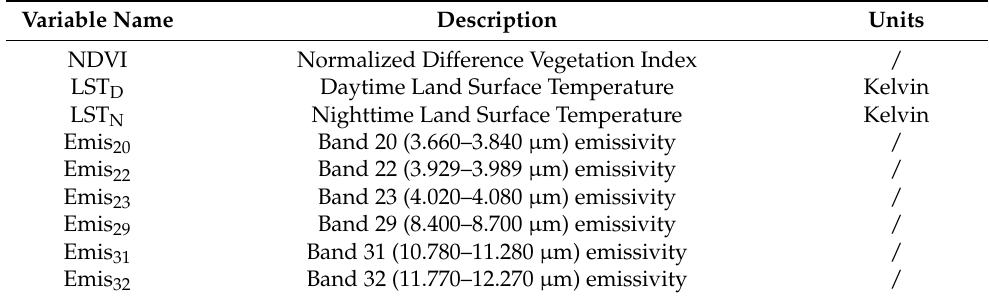
Table 2. Remote sensing data